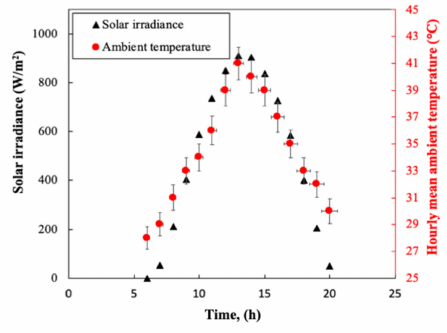
Figure 11. Variation of the solar irradiance and hourly ambient temperature with